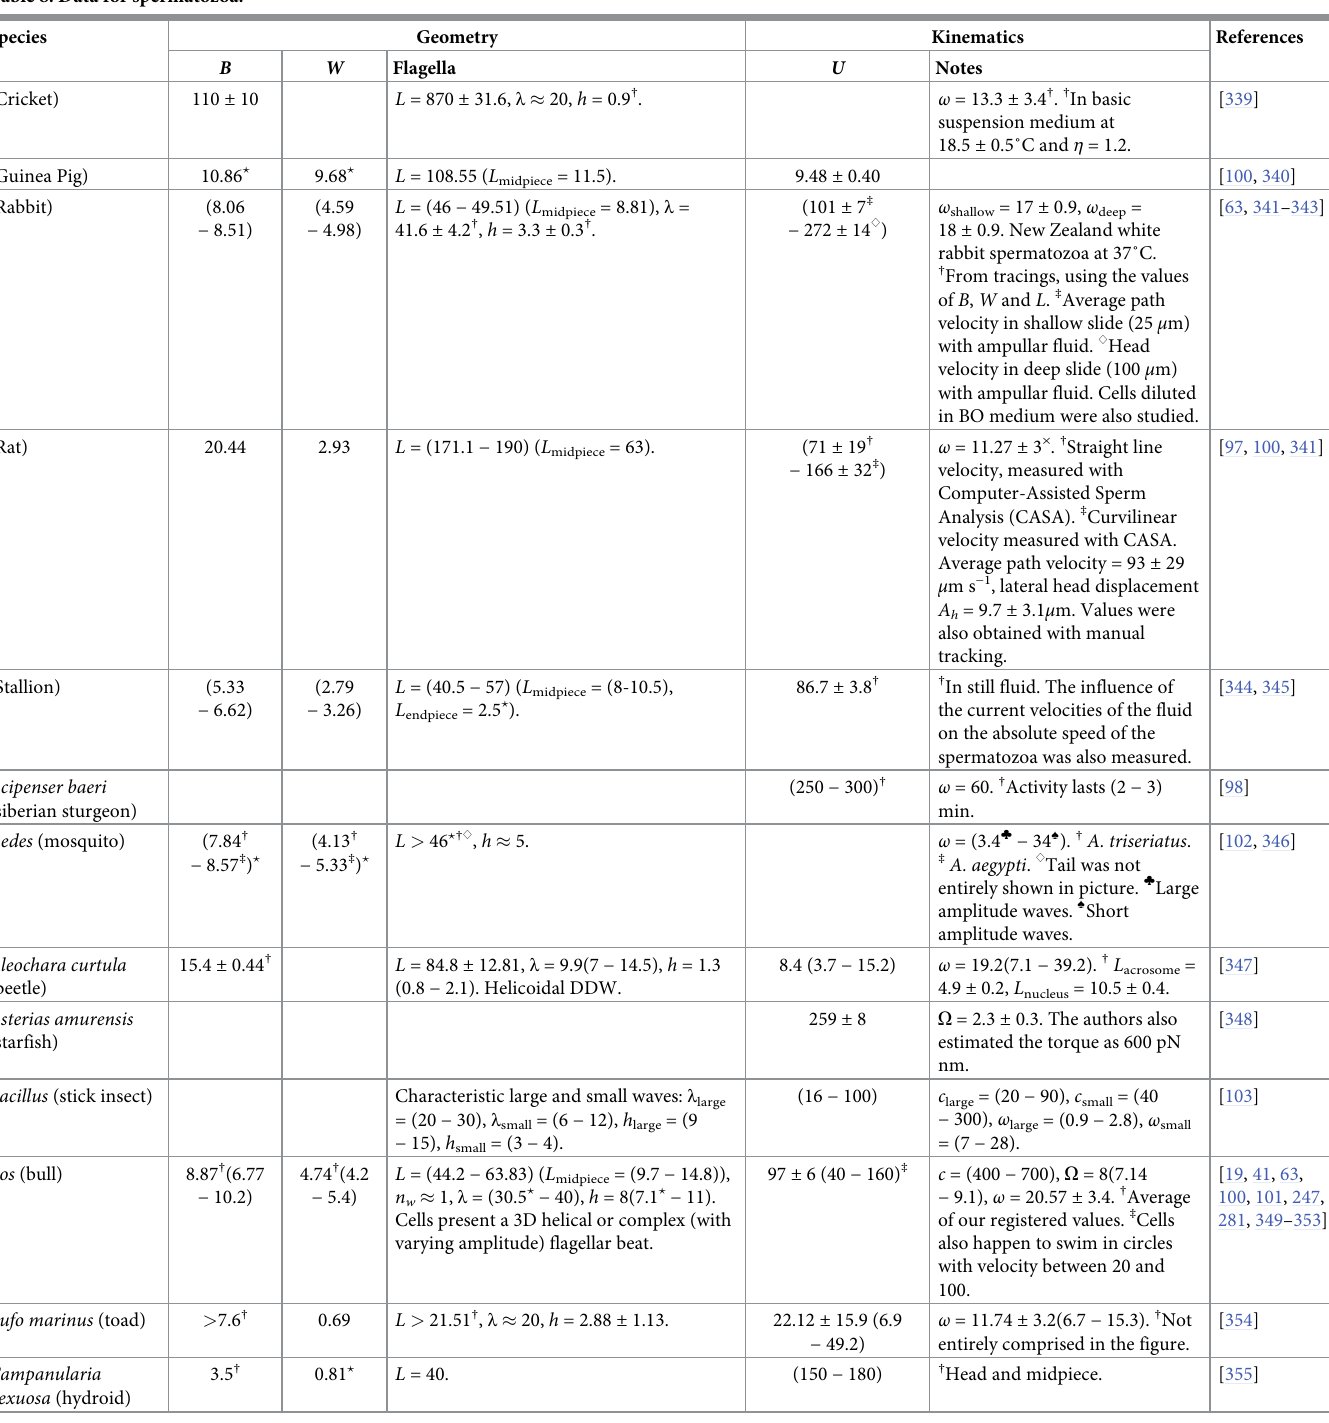
Table 8. Data for